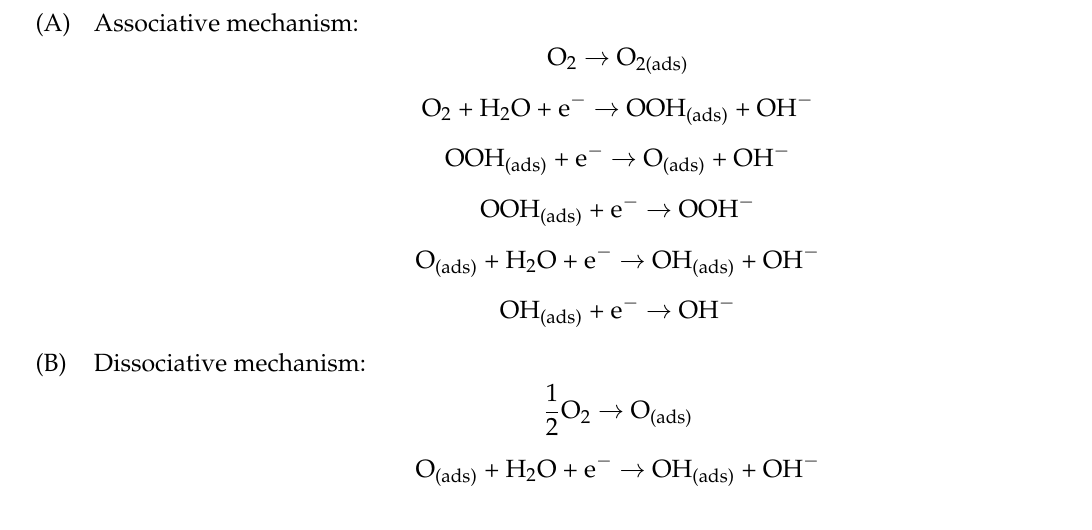
Figure 7. Faradaic current acquired at 0.75 V during the oxygen reduction reaction (ORR) in 0.1 M NaOH solution for all studied materials.